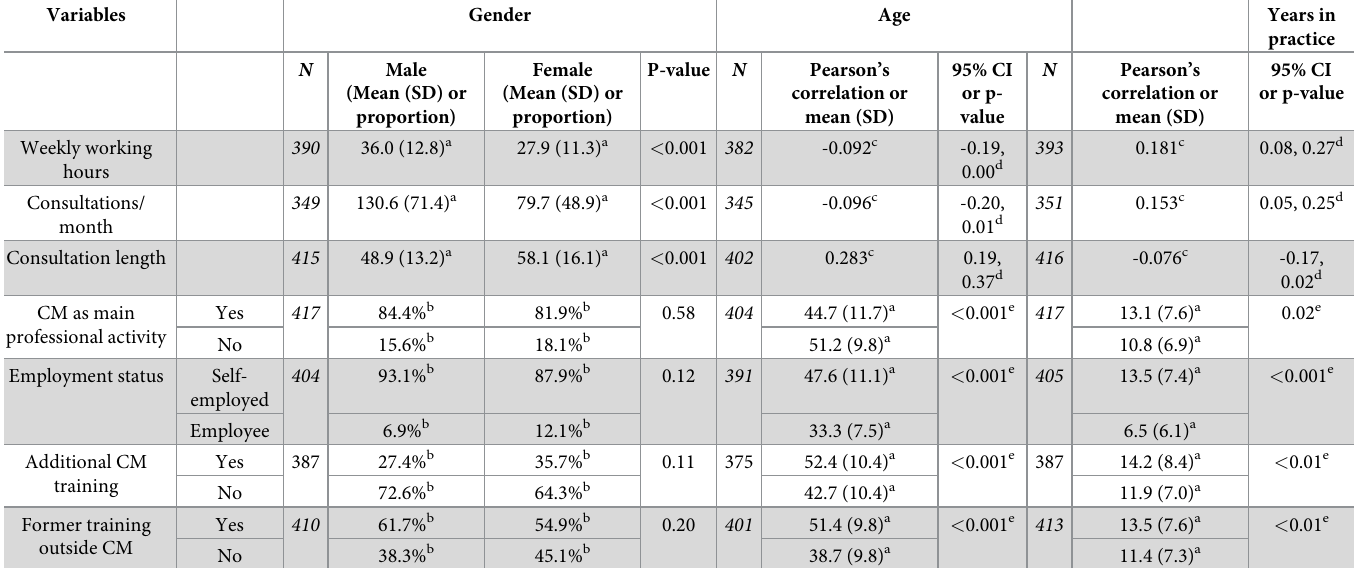
Table 5. Practice profile according to gender, age, and years in